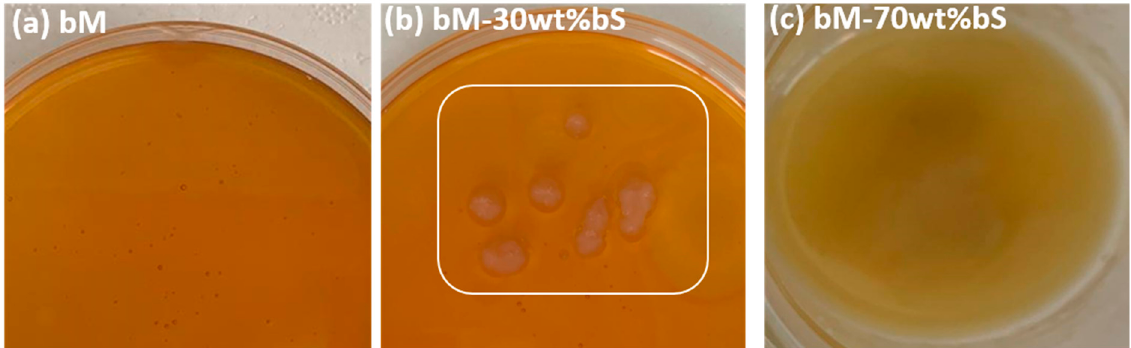
Figure 7. Scanning electron microscopy (SEM) micrographs of produced PS0, PS3, PS5 and PS7.